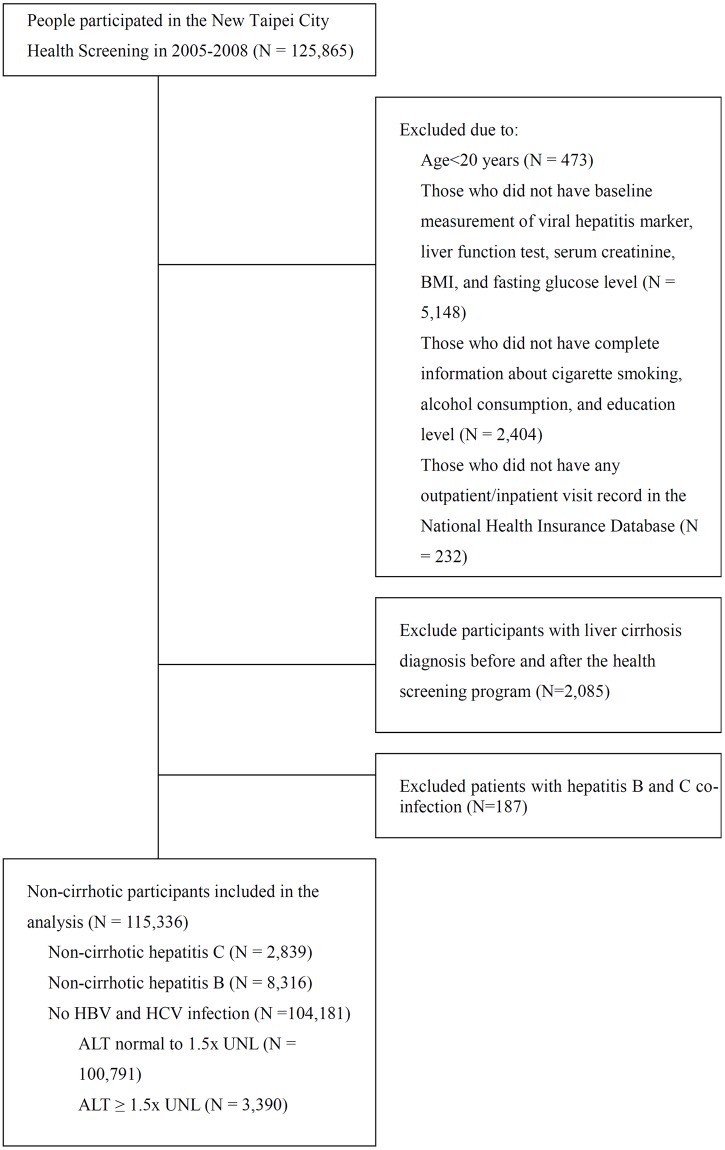
Flow chart for study participants’ enrollment.ALT, alanine aminotransferase; BMI, body mass index; HBV, hepatitis B virus; HCV, hepatitis C virus; UNL, upper normal limit.